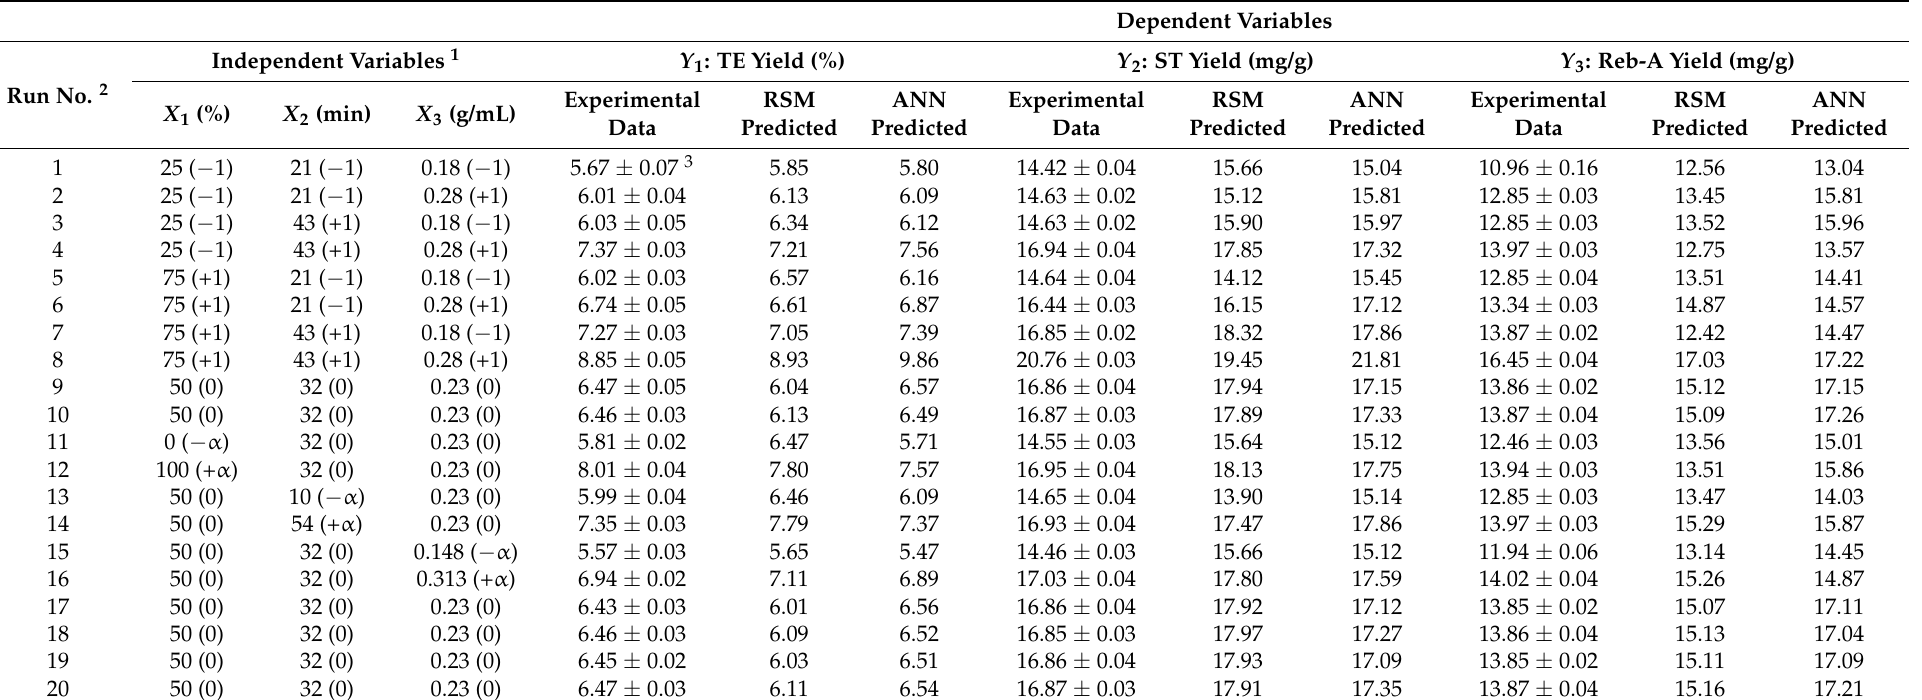
Table 2. CCD-specified experimental design with target responses as a function of the independent UAE process variables.